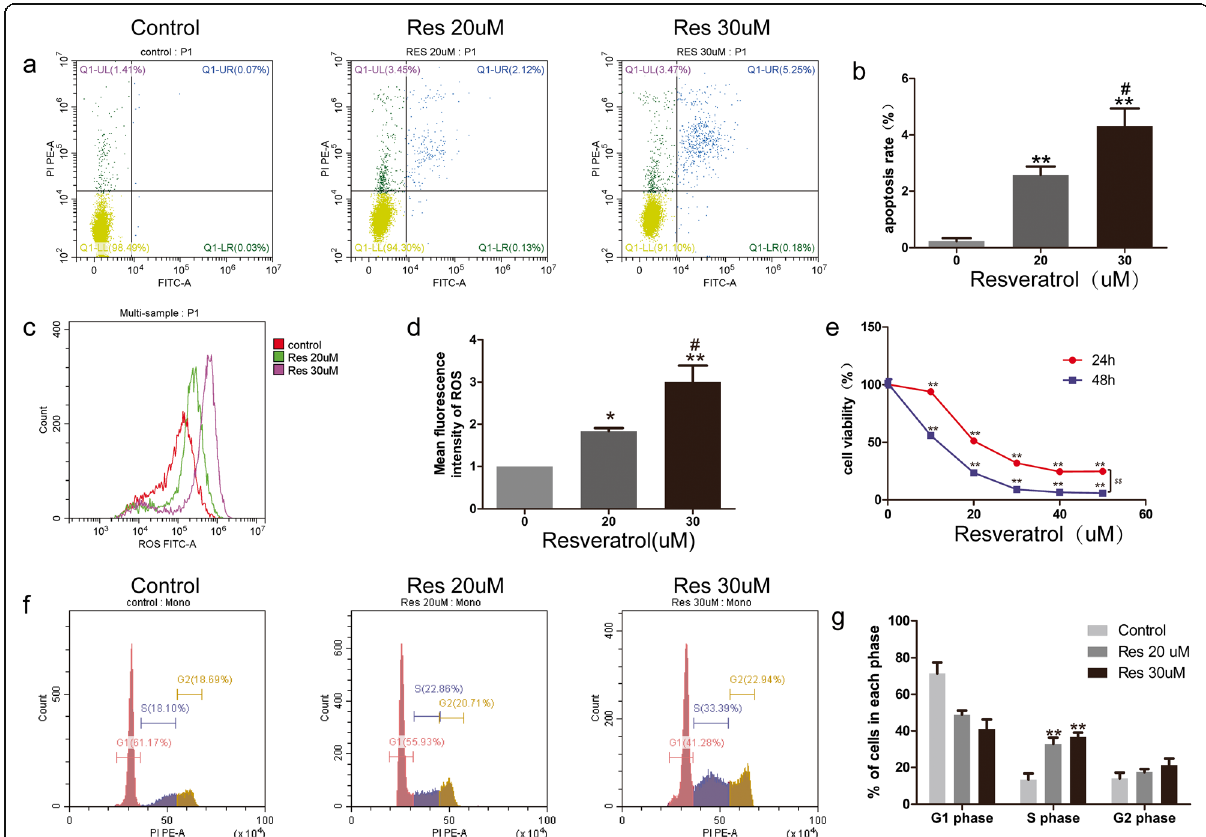
Fig. 1 The effects of resveratrol on apoptosis, ROS and cell cycle. a, b Flow cytometry analysis of apoptosis. c, d Measurement of ROS production by flow cytometry. e MTT assay detected on BPH-1 after treatment. f, g Cell cycle analysis by flow cytometry. Res represents resveratrol, * P < 0.05, ** P < 0.01(compared with vehicle-treated control), #P < 0.05, ##P < 0.01(compared with Res 20 μ M treating), $$P < 0.01(compared